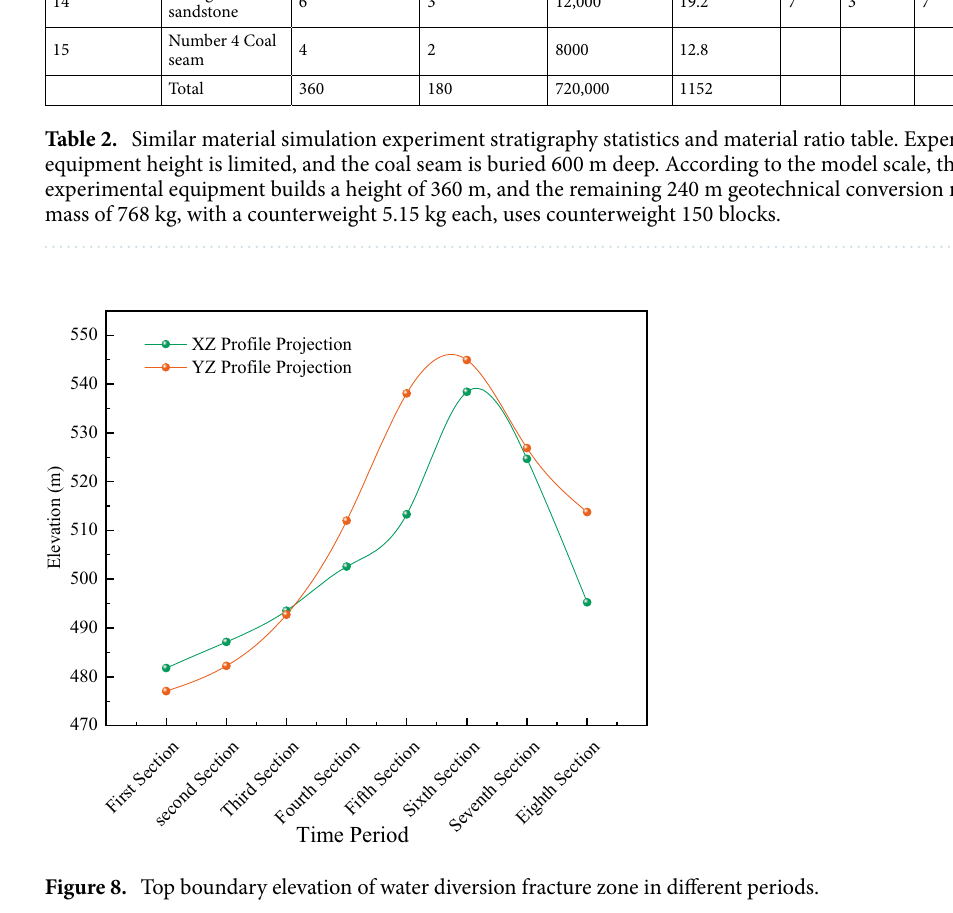
Figure 8. Top boundary elevation of water diversion fracture zone in different